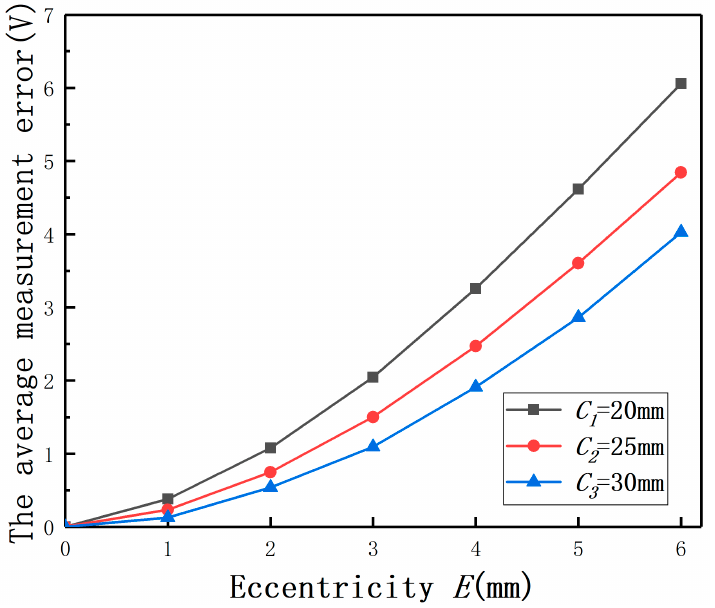
Figure 18. The average measurement errors under different radii.